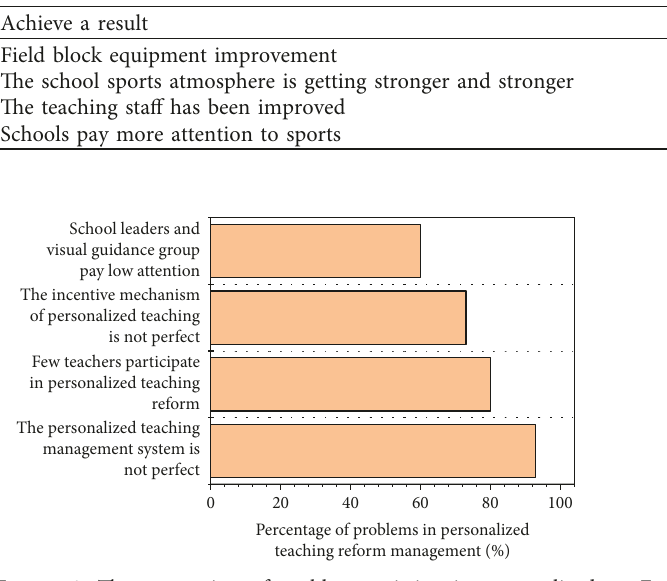
Table 13: The results obtained at the school level in personalized teaching reform ( n � 15).